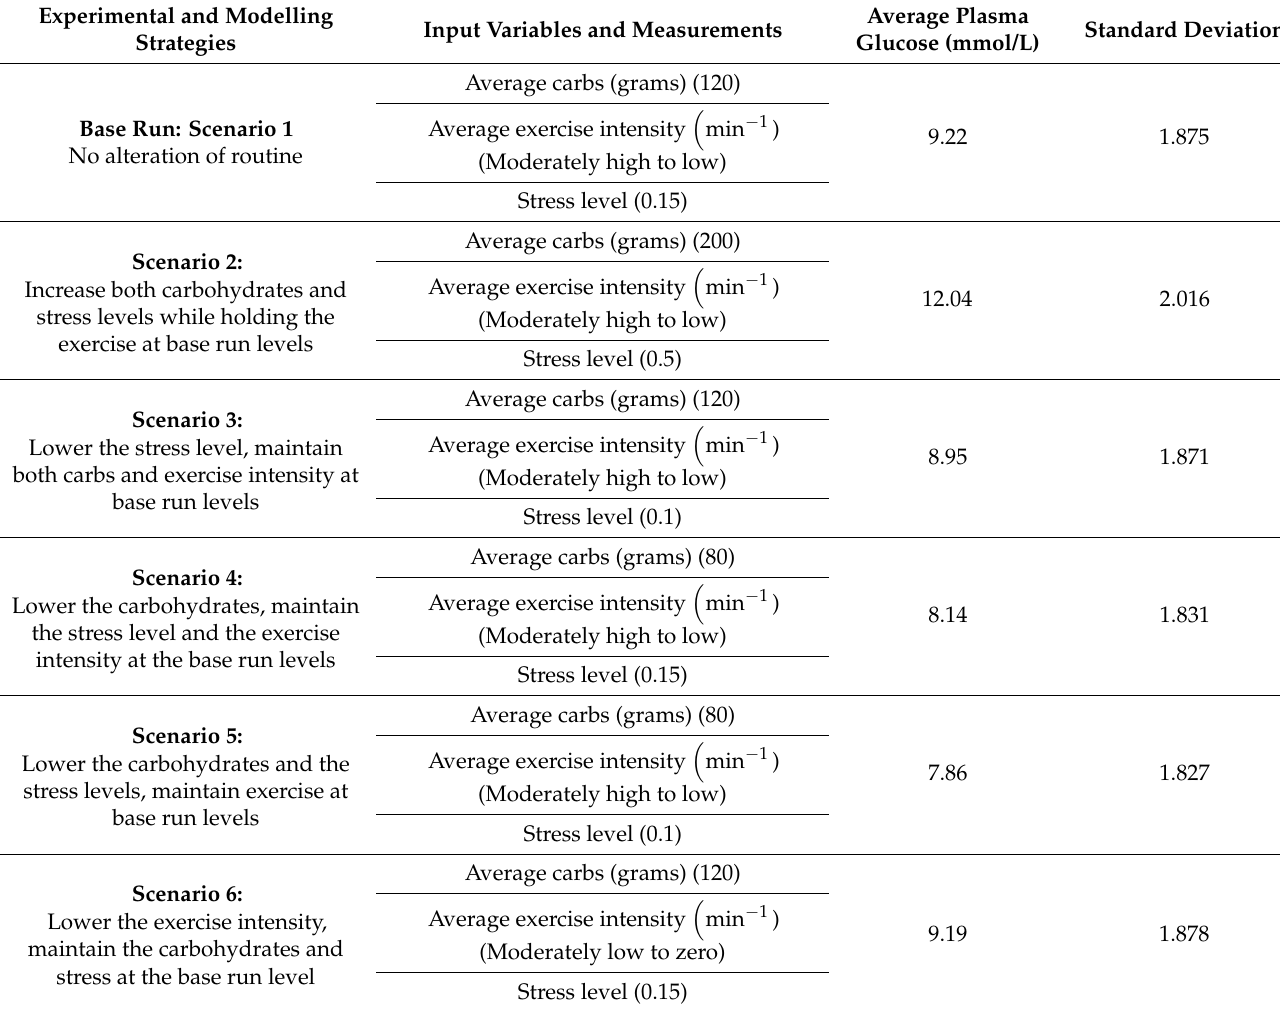
Table 2. Selected simulated plasma glucose output at different intervention